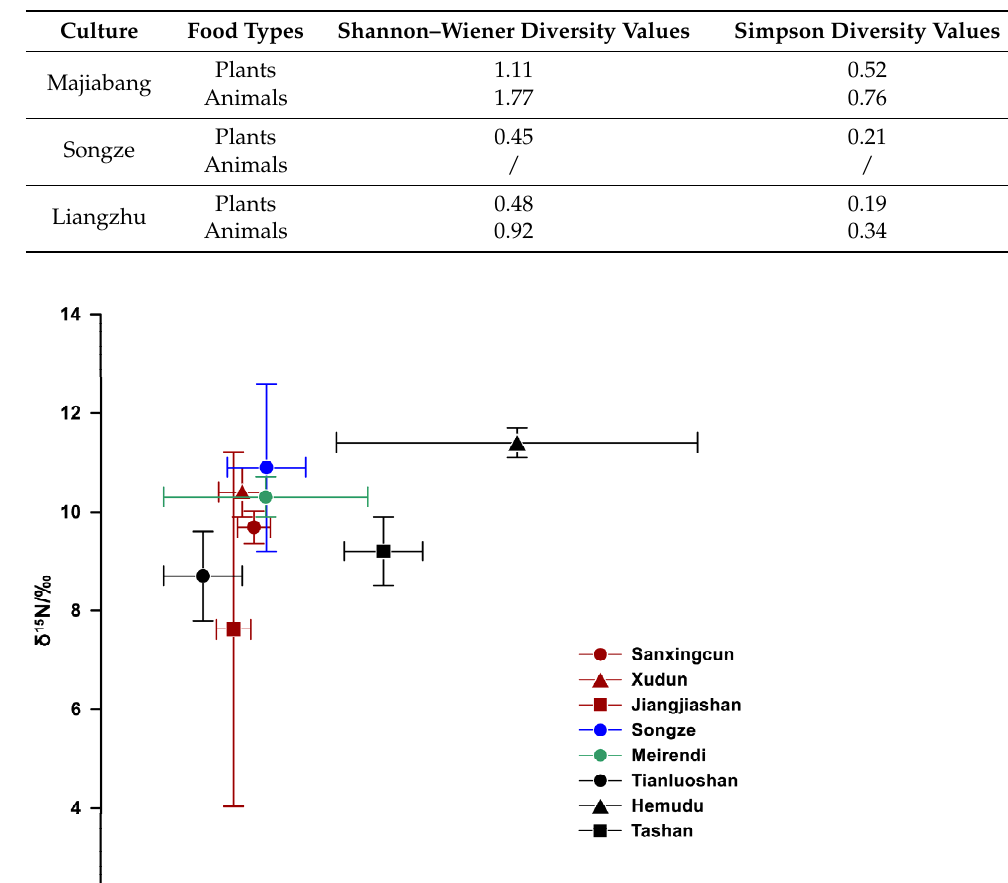
Table 3. Simpson and Shannon–Wiener diversity values for plant and animal foods in the area around Taihu Lake during each period.